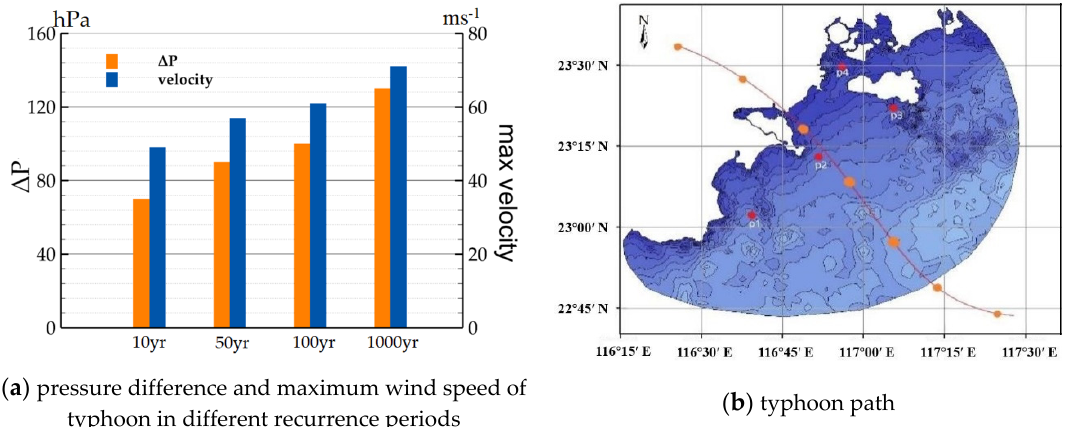
Figure 14. Typhoon intensity and its path (red circles are the selected control points).